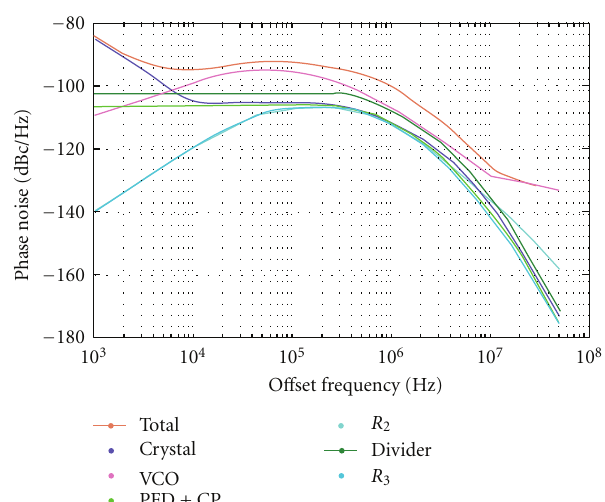
Figure 14: Simulated RTW VCO PLL phase noise.